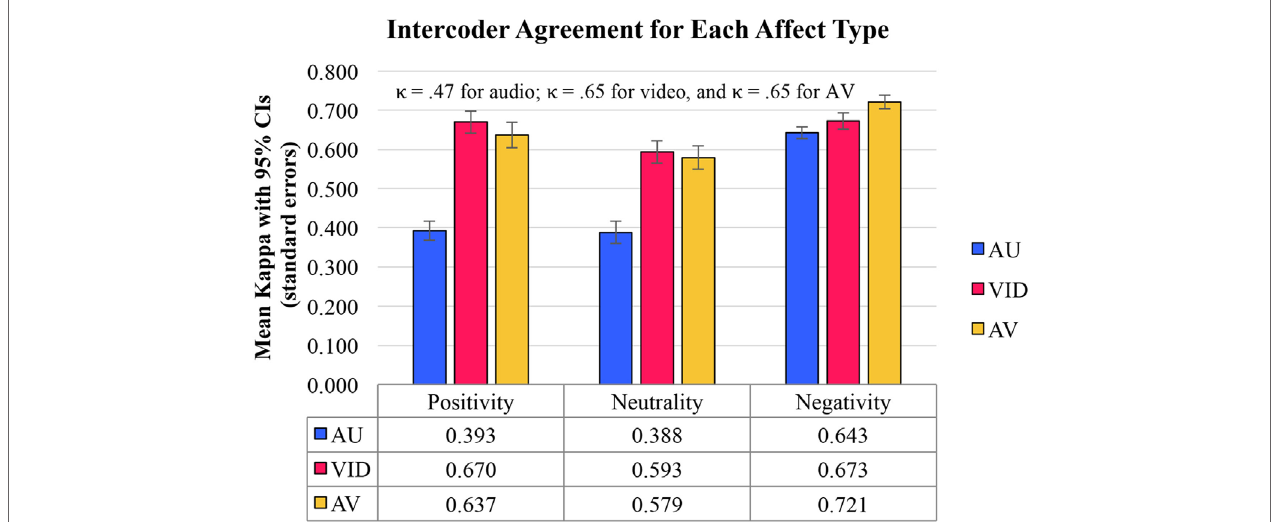
FigUre 1 | The data indicate that audio-only (AU) (blue bar in the right-hand cluster) was about as effective in transmitting negativity as video-only (VID) (red bar in the right-hand cluster), but that AU was considerably less effective in transmitting positivity or neutrality than the other conditions (blue bars in the middle and left-hand clusters). VID (red bars in the middle and left-hand clusters) was significantly more reliable than AU for positivity and neutrality. Only for negativity did the audio-video (AV) condition (yellow bar, right-hand cluster) yield highest agreement. 95% confidence intervals are included. Kappas at the top of the figure are means.